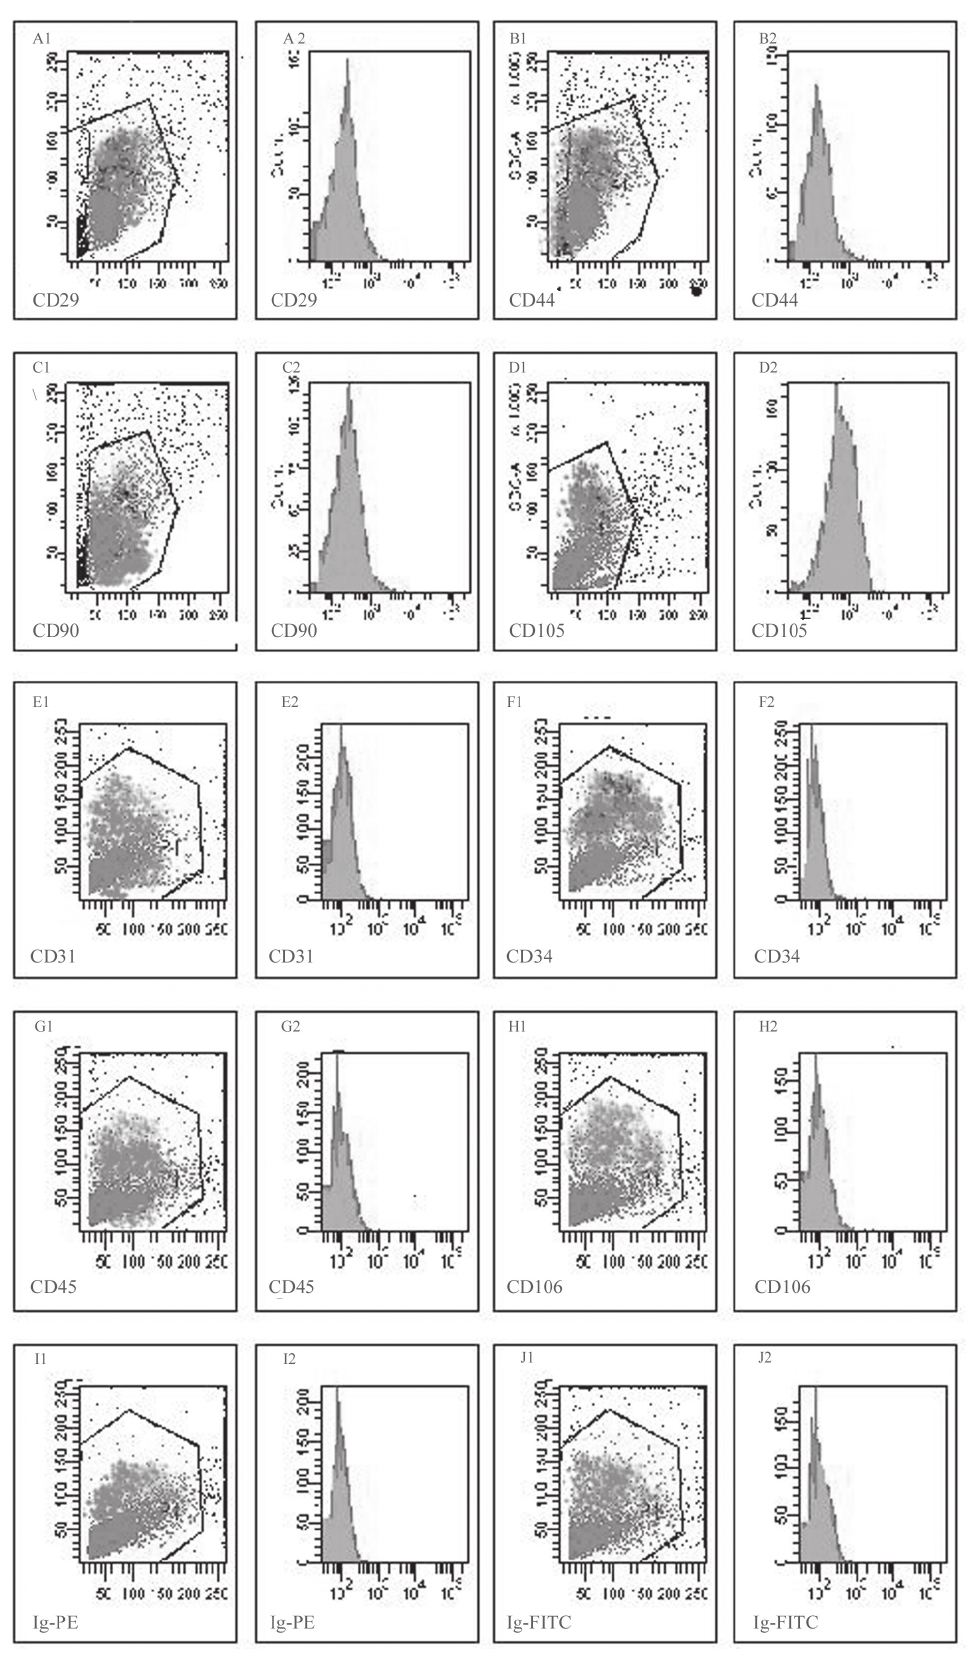
Fig. 3. Surface antigens of hAM-dMSCs in primary culture. In flow cytometry, hAM-dMSCs at pas- sage 3 were positive for CD29 (A1, A2), CD44 (B1, B2), CD90 (C1, C2) and CD105 (D1, D2), and negative for CD31(E1, E2), CD34 (F1, F2), CD45 (G1, G2) and CD106 (H1, H2). Mouse IgG conjugated with FITC or PE served as the negative controls (I1, I2) and (J1, J2). Data are shown as the mean ± standard error (S.E.)